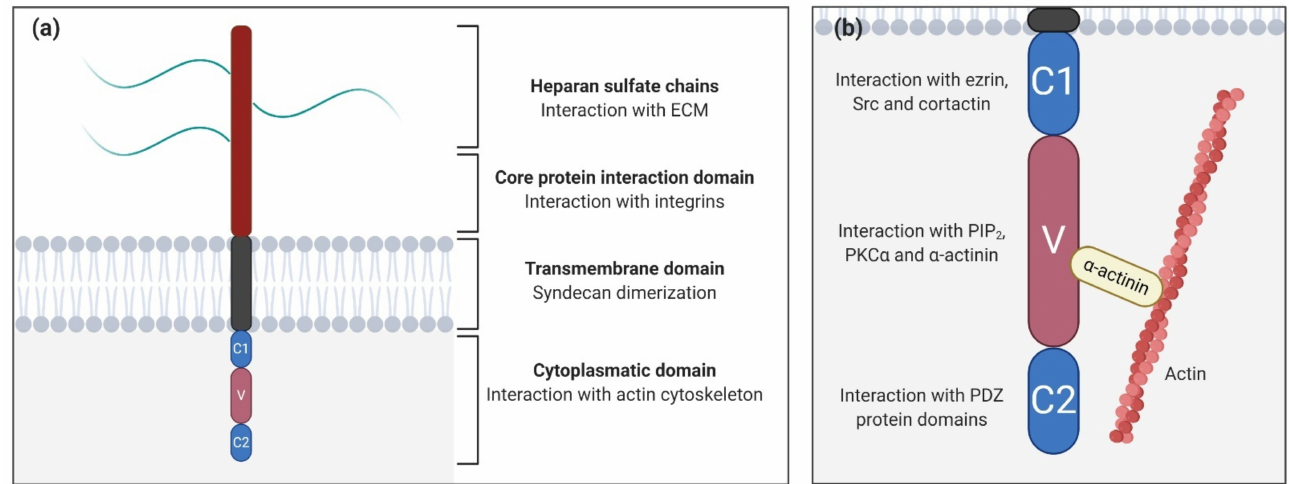
Figure 1. Syndecan structure. ( a ) Schematic representation of syndecan domains and their functions; ( b ) Close-up of the syndecan cytoplasmatic domain showing the constants (C1/C2) and the variable (V) regions and their potential interactions. The interaction between the variable region with α -actinin links syndecans to the